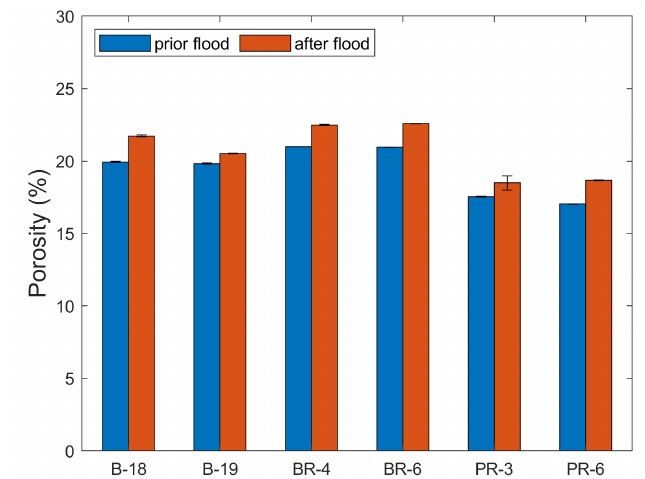
Figure 5. Measured porosity of the cores before and after the core flooding experiments. Blue bars show the initial values and the red bars indicate the measurements after the core flooding